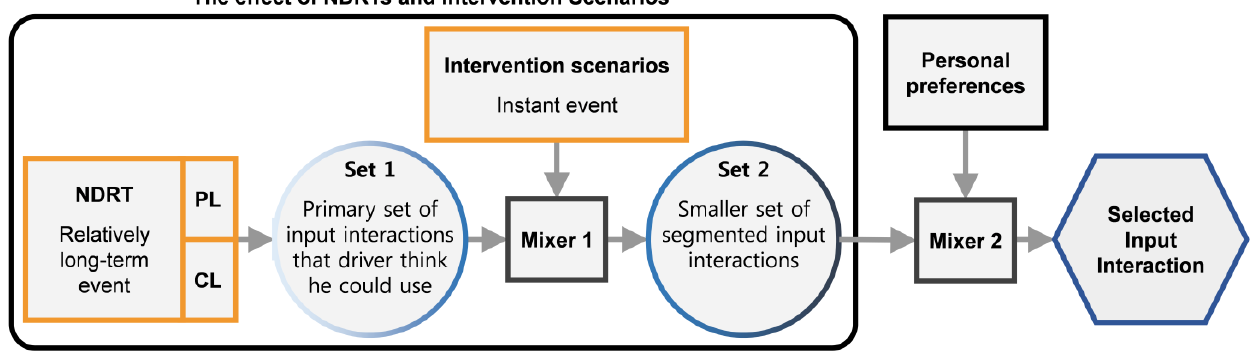
Figure 12. Driver’s decision-making model to intervene in the FAV.